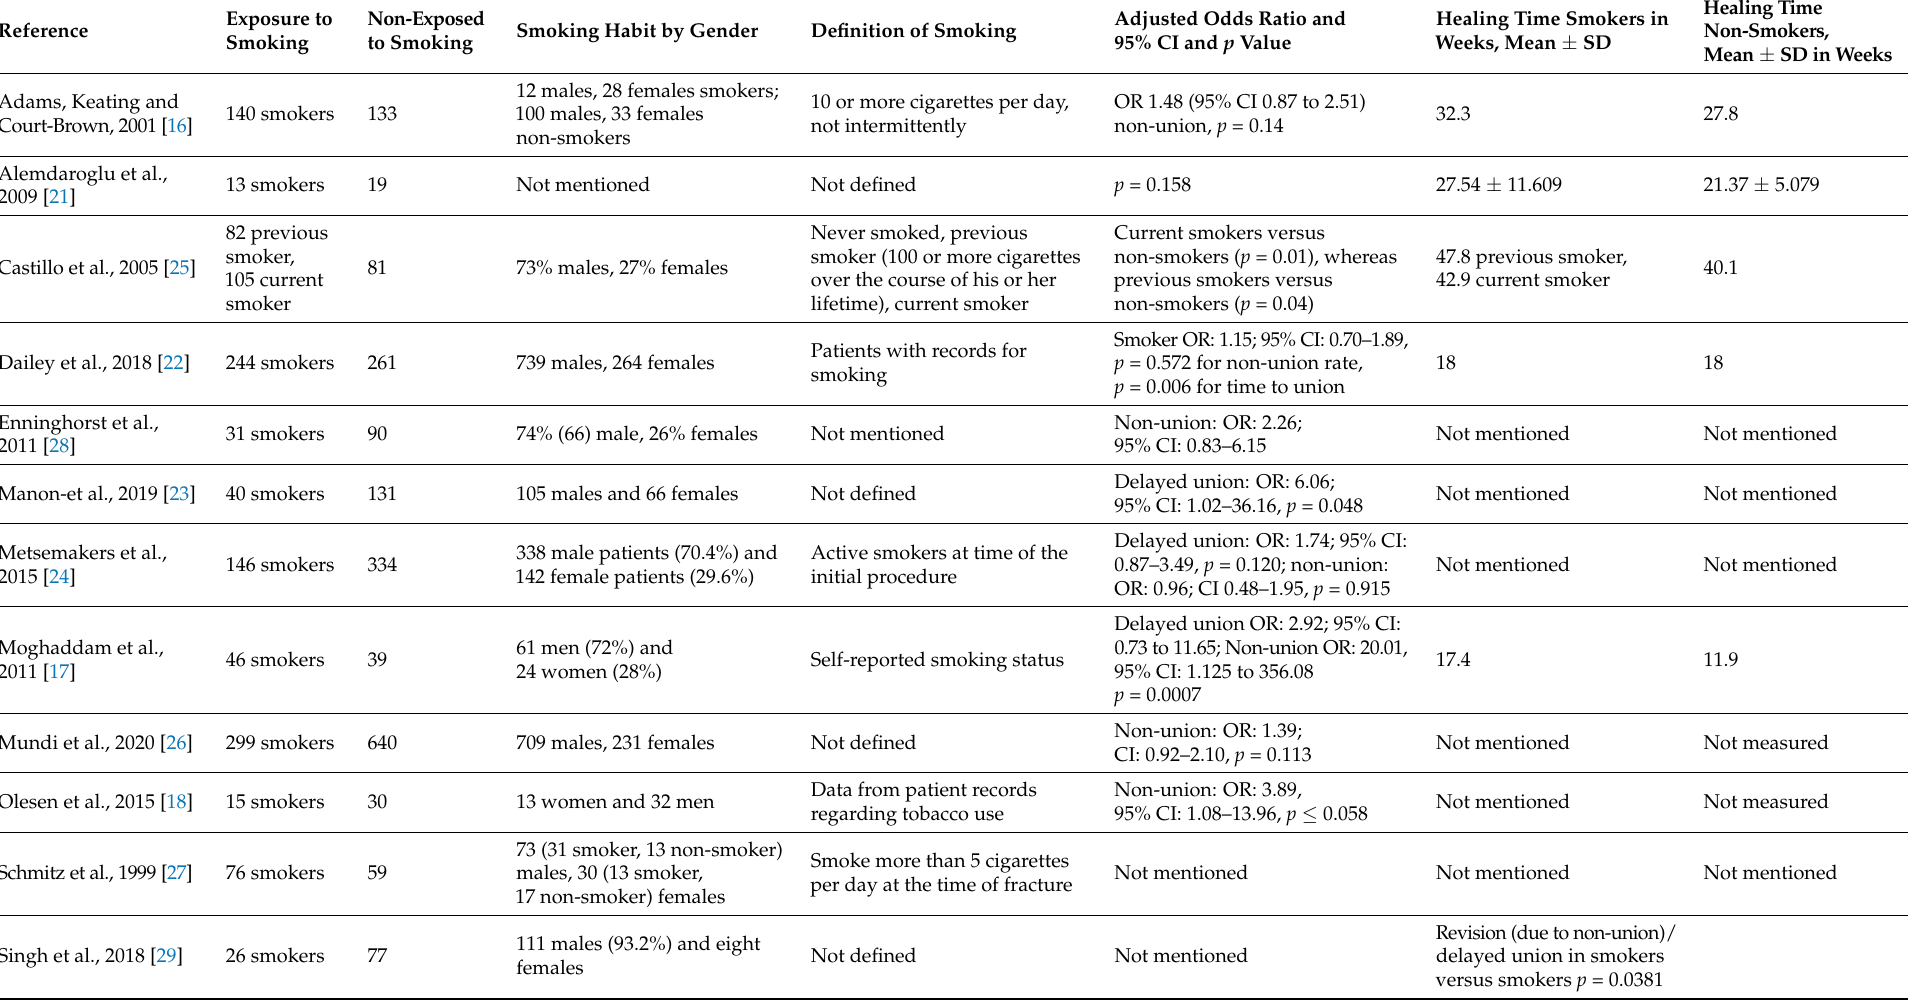
Table 2. Demographic characteristics and exposure to smoking of study